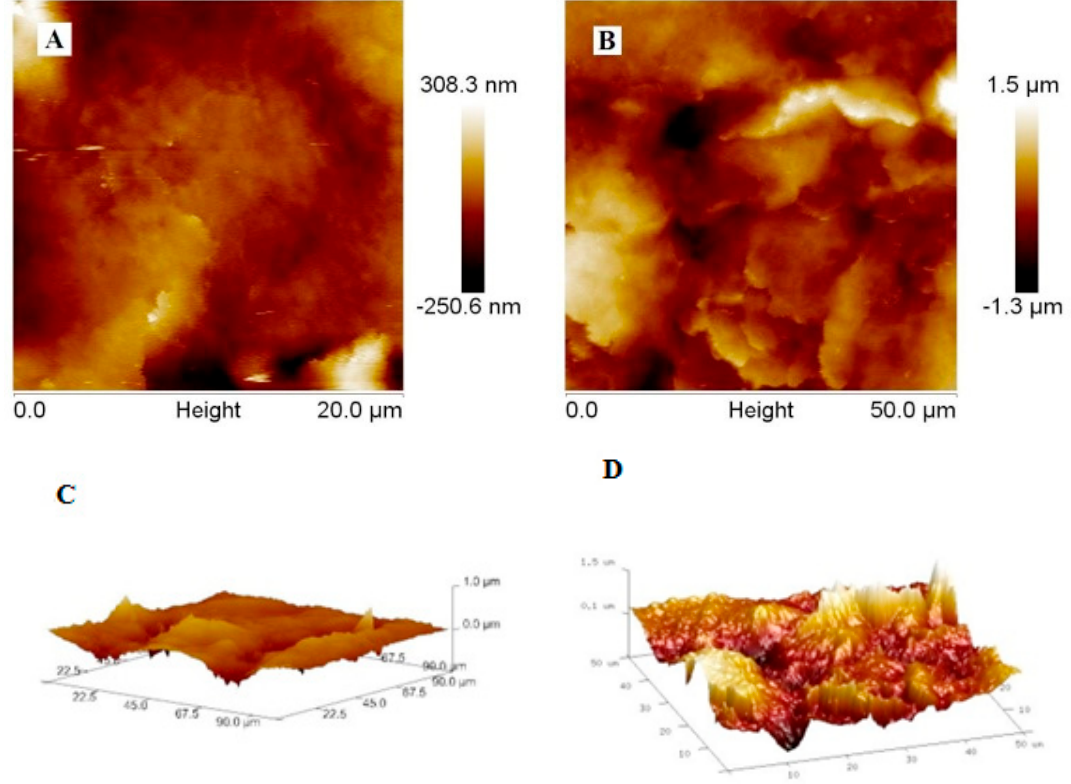
Figure 5. AFM images of GR electrodes: ( A ) bare electrode, ( B ) modified with poly-PQ using 1 polymerization cycle, 2D and respectively ( C and D ) 3D projections.